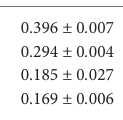
TABLE 4 Comparisonofresultsfordifferentinputfeatureswheremetricsaregivenintermsoftheaverageoverthe10randomseeds ± thestandard deviation.Thesemetricsareevaluatedinlog ofX-raymagnitude.